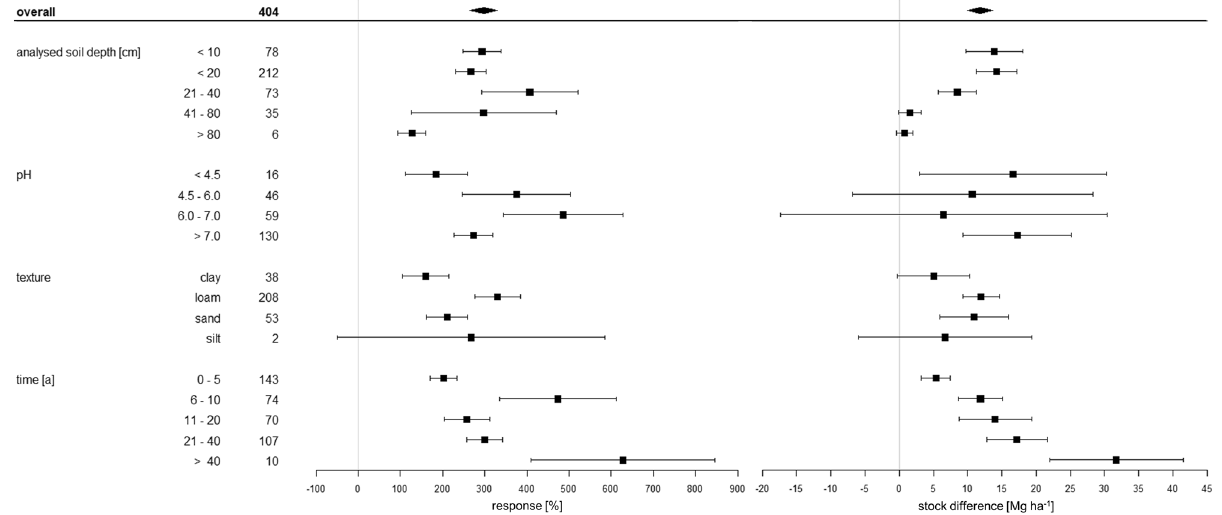
Figure 6. Relative response of soil organic carbon stocks [%] and absolute difference in soil organic carbon stocks [Mg ha −1 ] influenced by analysed soil depth [cm], soil pH, soil texture, and time under